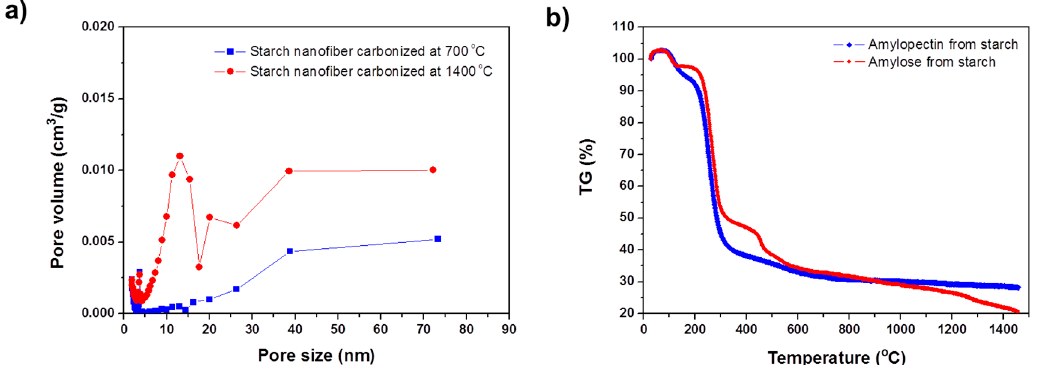
Figure 2. ( a ) Pore-size distributions of starch nanofibers carbonized at 700 and 1400 °C, calculated by applying density functional theory to nitrogen adsorption isotherms; and ( b ) thermograms showing the percent weight loss as a function of temperature for amylose and amylopectin from starch.